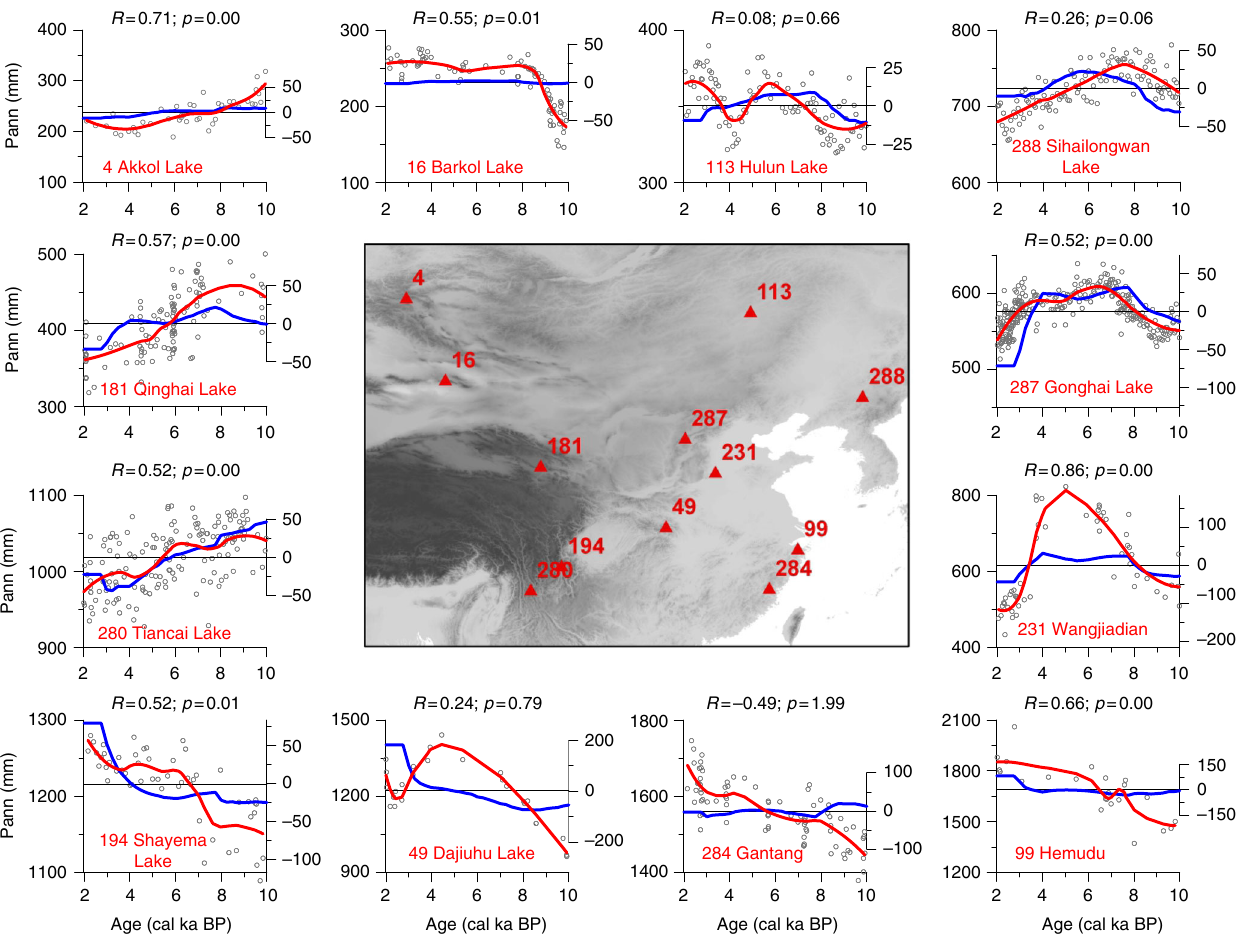
Fig. 3 Reconstructed and simulated precipitation of selected sites in China and Mongolia. Pollen-based reconstructions of annual precipitation (mm/year; black circles are original data points, red lines is loess smoothed values (span: 0.5, left scale) compared to simulated precipitation anomalies (mm/year, blue lines, right scale) using a minimal empirical model of selected sites. Correlation coef fi cient and p -values are indicated (i.e., between loess-smoothed reconstructions and simulated time-series from the respective grid-cell). Central map shows the locations of the sites: only sites that had a suf fi ciently high-resolution and a reliable age model were selected (see Supplementary Table 3 for further details). (Note axes are not on the same scale.)